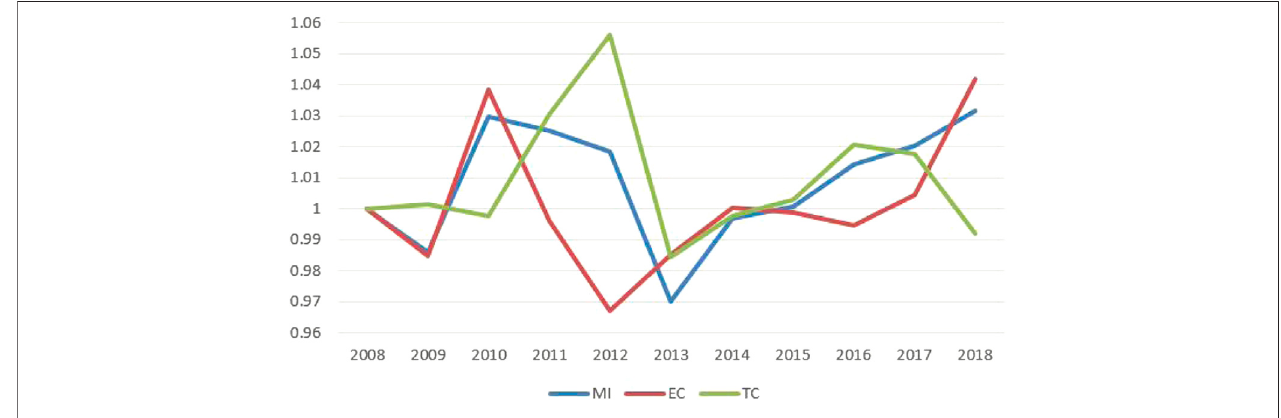
FIGURE 2 | Urban green economic ef fi ciency trends, 2008 – 2018.